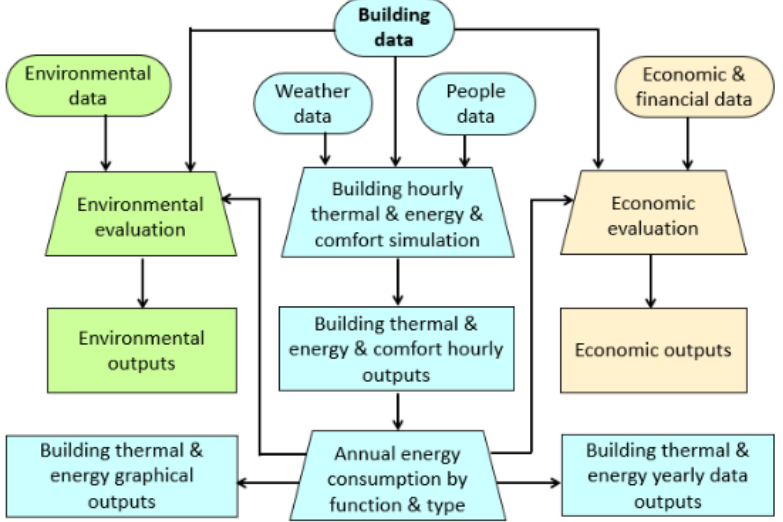
Figure 1. Global block diagram of the SEnergEd calculation methodology.